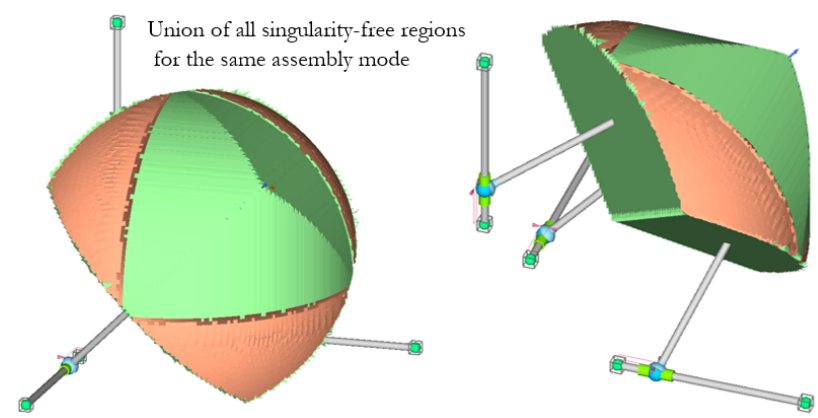
Figure 20. Enlarged operational workspace for assembly mode ⊕ (two different